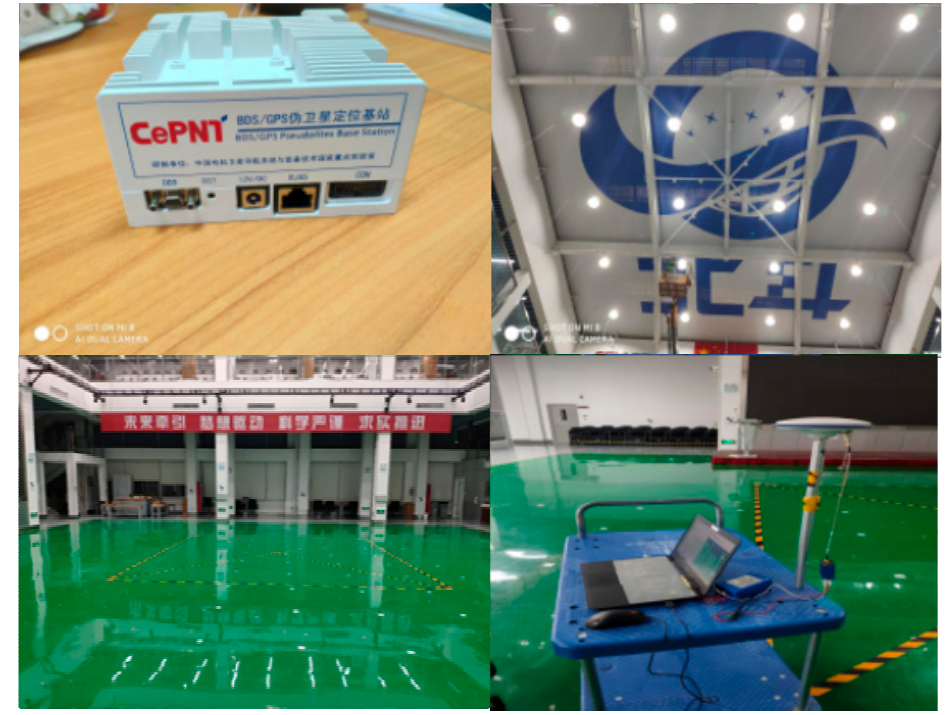
Figure 10. Wireless test environment.